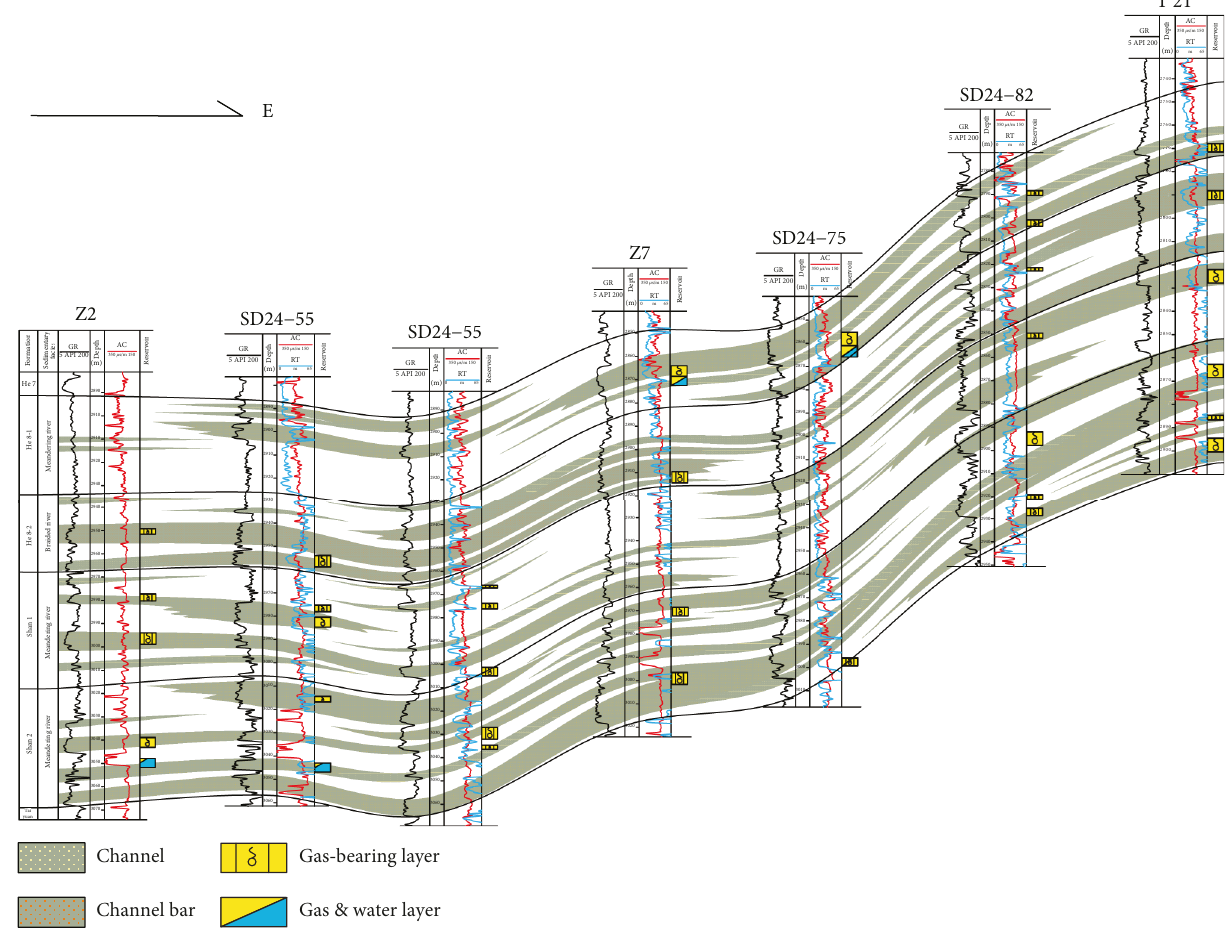
Figure 2: Sedimentary pro fi le between